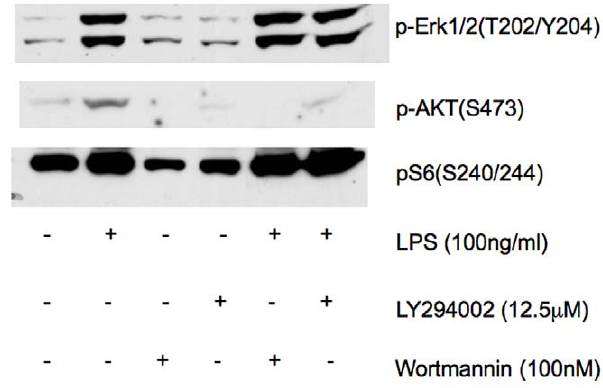
Figure 7. TNF- a secretion of LPS-treated macrophages oc- curred after mTORC1-S6K activation. Conditioned media and cell lysates of RAW cells treated with 100 ng/ml of LPS were collected at various time points. The immunoblots probing for pS6(S240/244) (A.), and the averages of TNF- a levels in the conditioned media from triplicate experiments with error bars representing standard deviations (B.) are shown here. mTORC1-S6K activation occurred as soon as 30 min after LPS when TNF- a levels were not detectably increased at that time point. PLoS ONE |